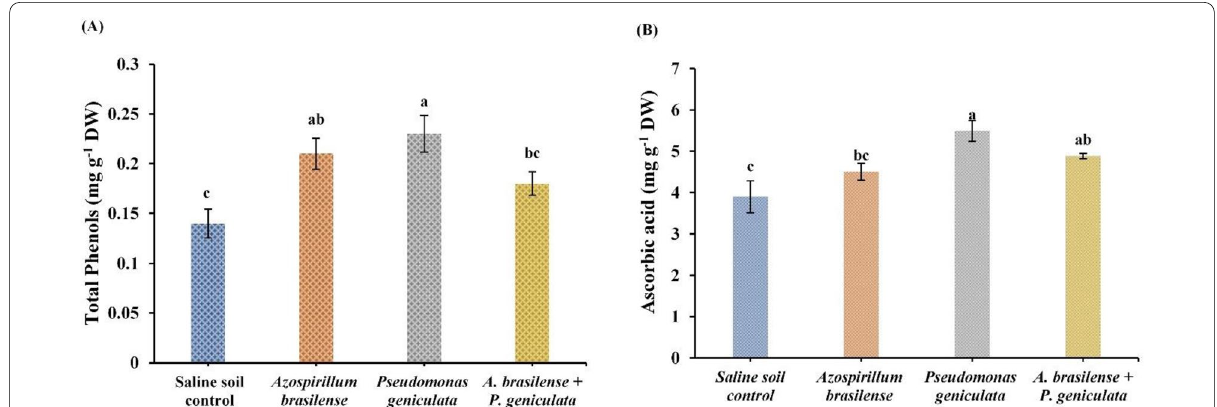
Fig. 4 Effect of the inoculation with Azospirillum brasilense , Pseudomonas geniculata individually or co-inoculation on ( A ) Total Phenols (mg g − 1 DW); ( B ) Ascorbic acid (mg g − 1 DW) contents of flax plants ( Linum usitatissimum ) grown in saline soil. Bars represent the mean of three replicates (n 3), vertical bars indicate standard error. Different letters indicate significant difference among means according to LSD test at p < 0.05. FW = ± fresh weight